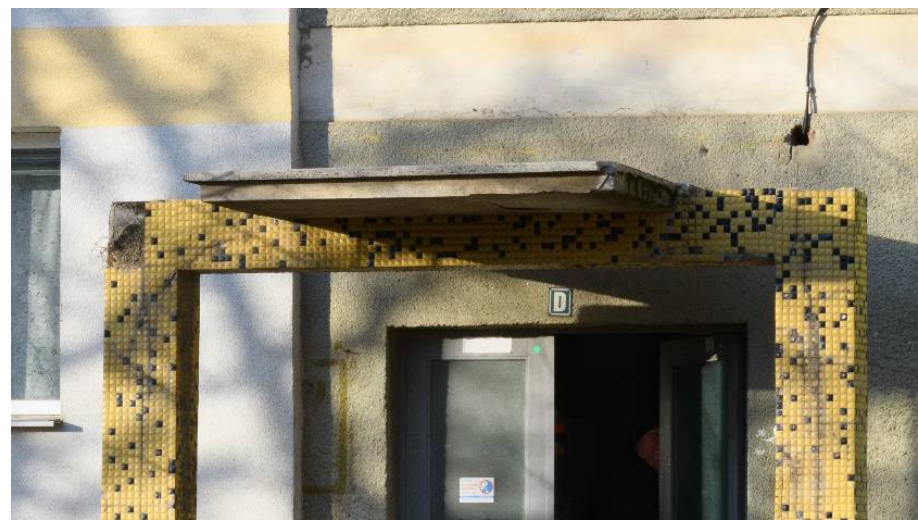
Figure 4. Non-figurative mosaic applied on the blocks of the Arini neighbourhood. (Source: Petru Palamar).